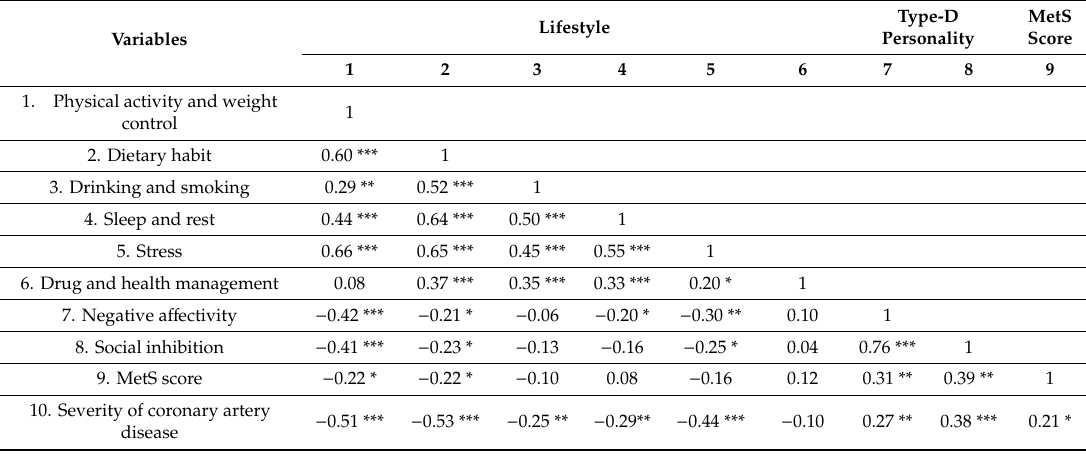
Table 3. Correlation between behavioral-psychological variables and predictors for CAD prognosis.